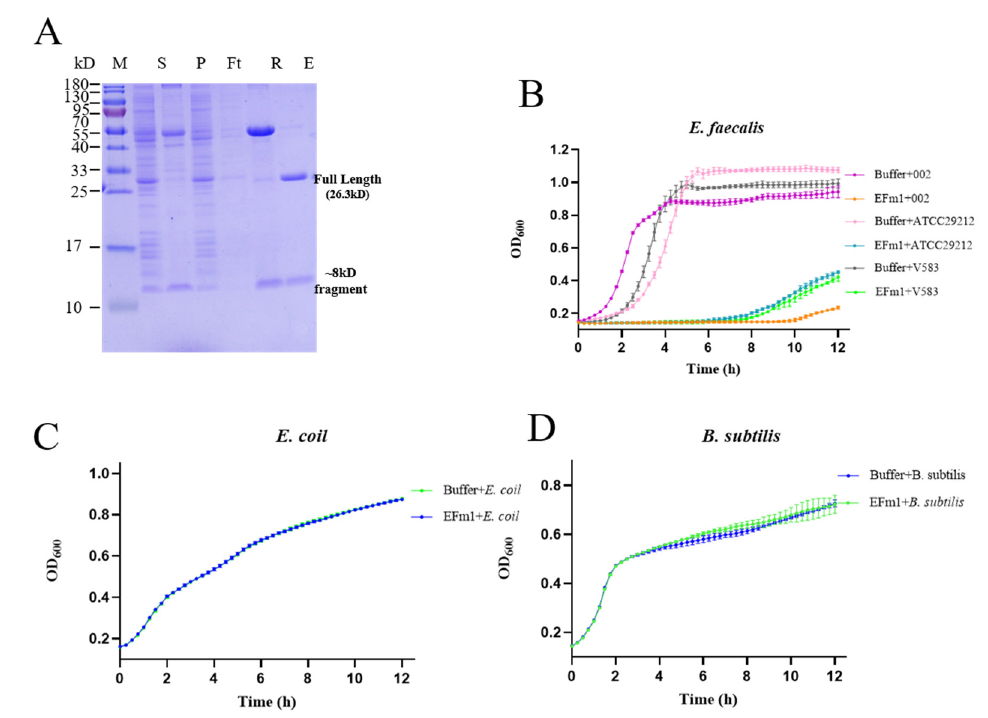
Figure 1. Expression and lytic activity of EFm1. ( A ) SDS-PAGE analysis of EFm1 expression. S, P, Ft, E and R represent supernatant, pellet, flow through, elution and resin, respectively; ( B ) The growth curves of 002, ATCC29212 and V583 after adding EFm1; the mean ± s.e.m is shown; ( C ) The growth curves of E. coli BL21(DE3) after adding EFm1; the mean ± s.e.m is shown; ( D ) The growth curves of B. subtilis CU1050 after adding; the mean ± s.e.m is shown.